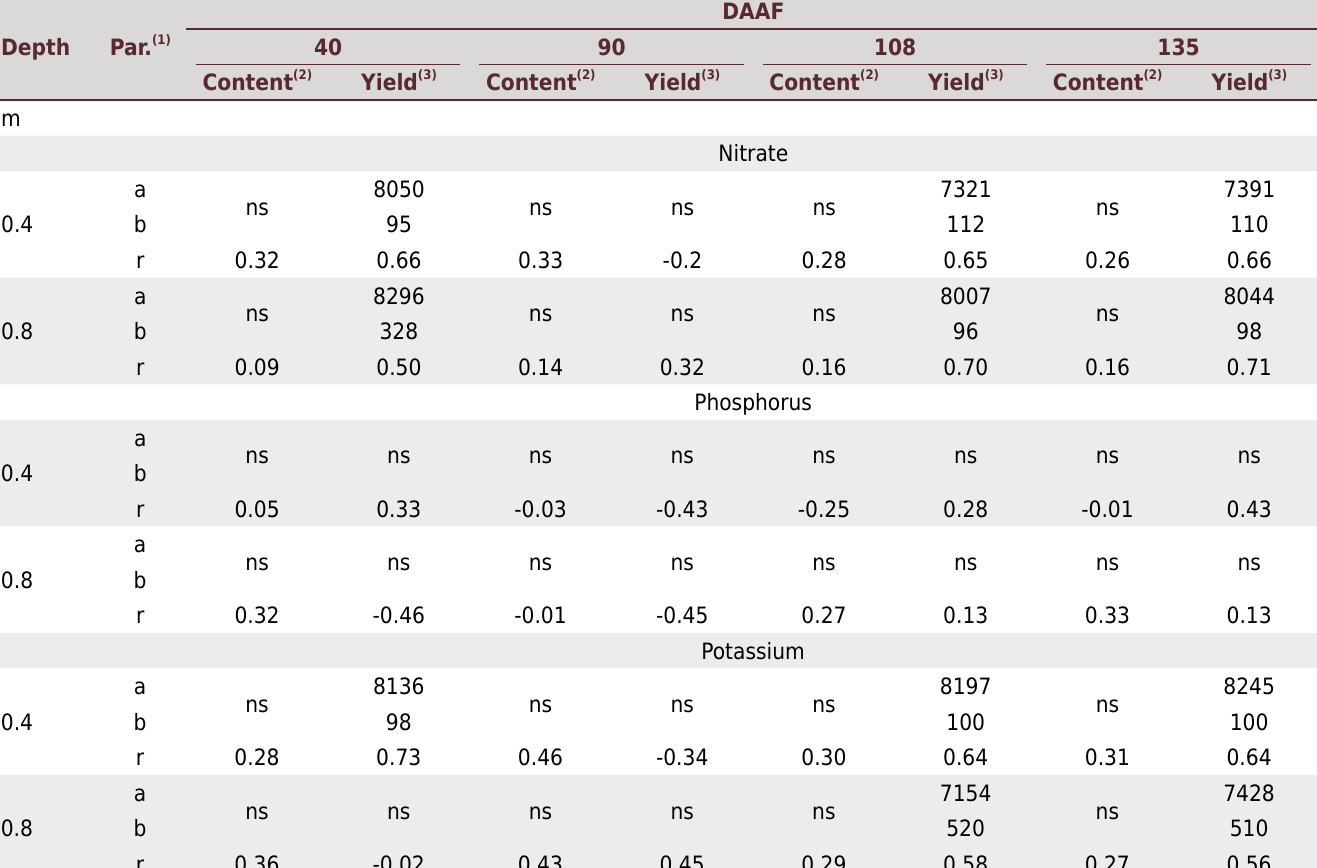
Table 4. Correlation of nitrogen, phosphorus and potassium contents in the soil solution with concentrations in corn leaf tissue and grain yields in a Typic Hapludox subjected to 12 years of fertilization with with pig slurry, mineral fertilizer and pig slurry combined with mineral fertilizer, at two depths (0.4 and 0.8 m) and on different days after the application of fertilizers (DAAF) Depth Par.